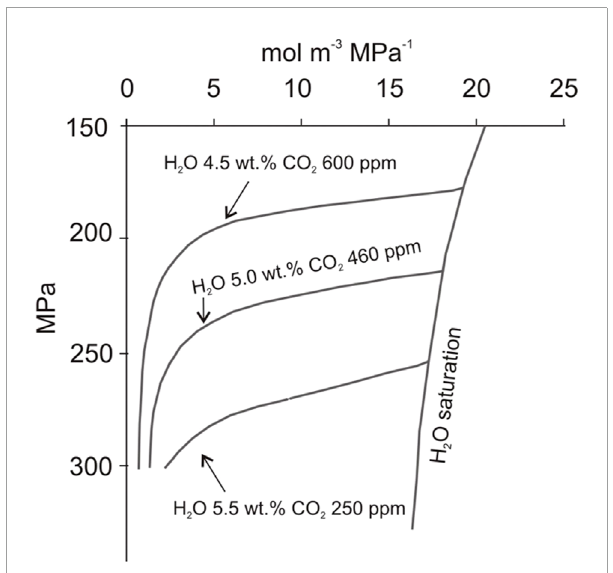
FIGURE 2 Theoretical P -X[H 2 O+CO 2 ] degassing curves for the CF magma, calculated for 0.2 MPa decompression steps and P < 300 MPa, where the mass of exsolved volatiles X[H 2 O+CO 2 ] is expressed as moles of volatile per m 3 of trachybasaltic magma ( T = 1 . 120 ° C, ρ = 2 . 650 kg m −3 ). The plot evidences markedly different degassing styles between mixed H 2 O+CO 2 vs water-bearing magmatic systems: in fact, for narrow ranges of decompression steps, the mass of volatiles released by CO 2 -bearing magmatic systems increases very steeply relative to water-bearing magmatic